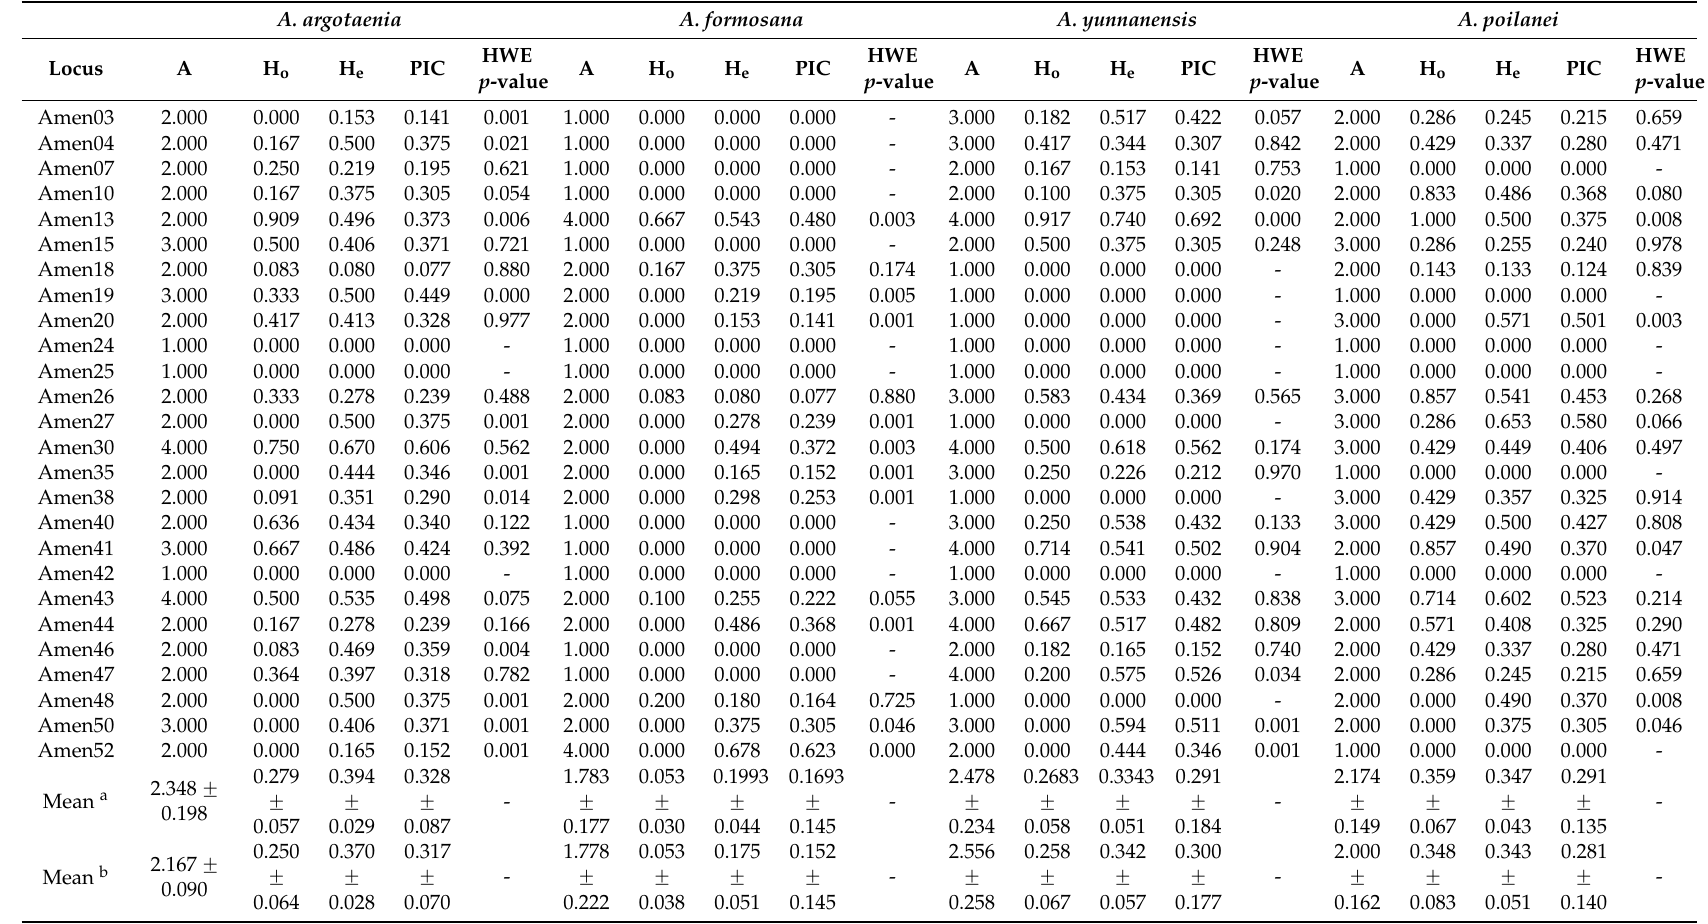
Table 1. Characterization of the selected 26 EST-SSRs from four Amentotaxus